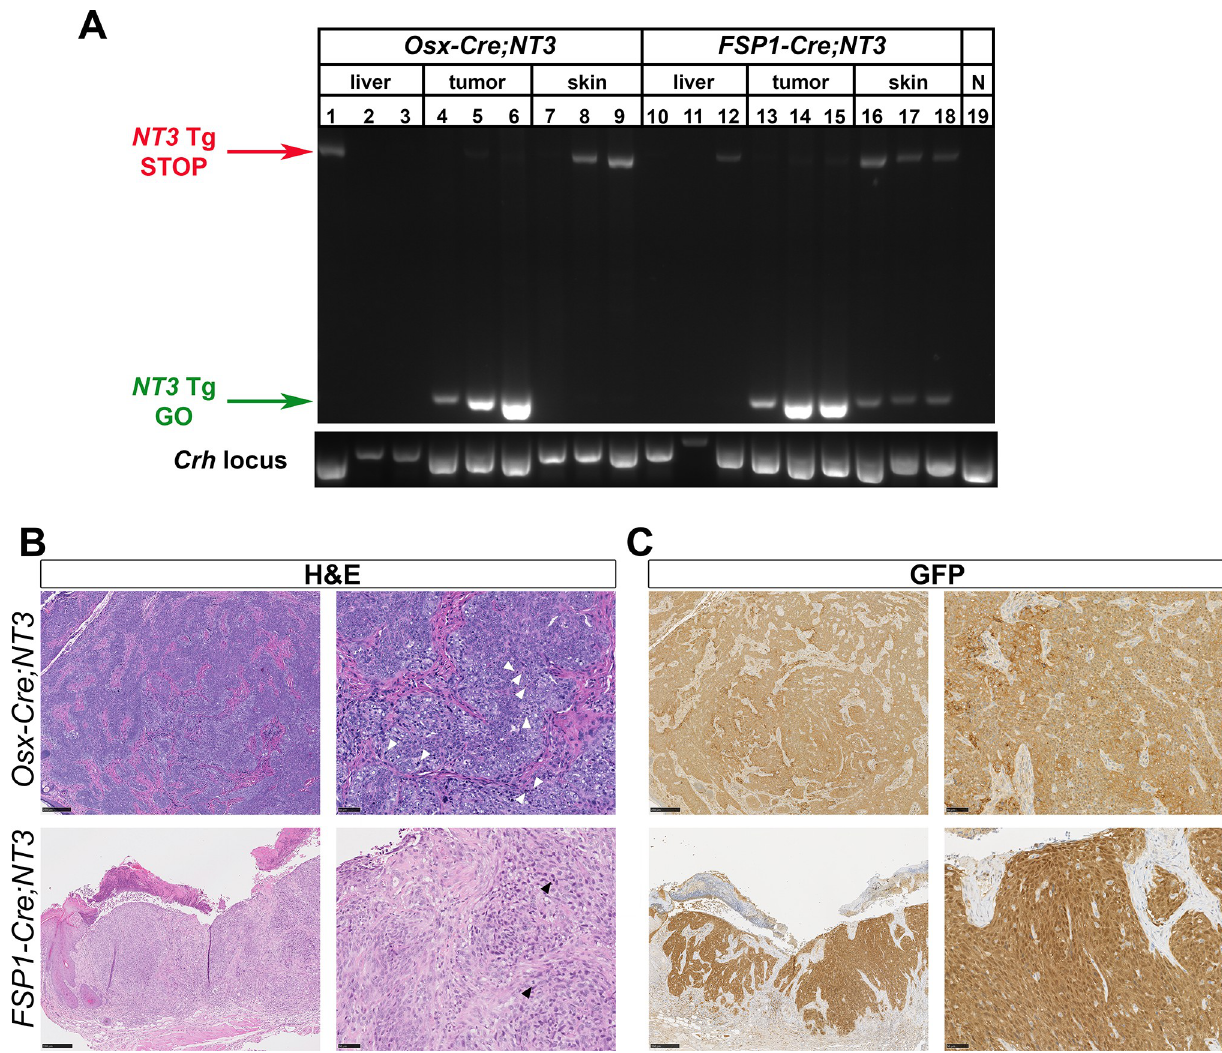
Fig 2. Tumors derive from NT3 -transgene expressing cells. (A) gDNA PCR of whole tissue from liver, tumor, or skin in Osx-Cre;NT3 , FSP1-Cre;NT3 , or Ctrl animals. Amplification across the loxP/Neo-STOP/loxP cassette in the intact allele or after Cre -mediated recombination. NT3 Tg = NT3 transgene. N = Cre -negative, Ctrl . Crh , corticotropin releasing hormone. (B) Representative H&E staining or (C) immunohistochemistry for GFP which is expressed by the NT3 transgene as well as the Cre construct in Osx-Cre mice. ( left images ) 10x, scale bars = 250 μ M and ( right images ) 40x magnification, scale bars = 50 μ